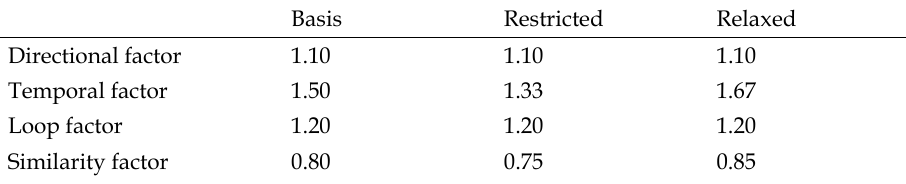
Table 1. Implementation of the branch & bound generation technique